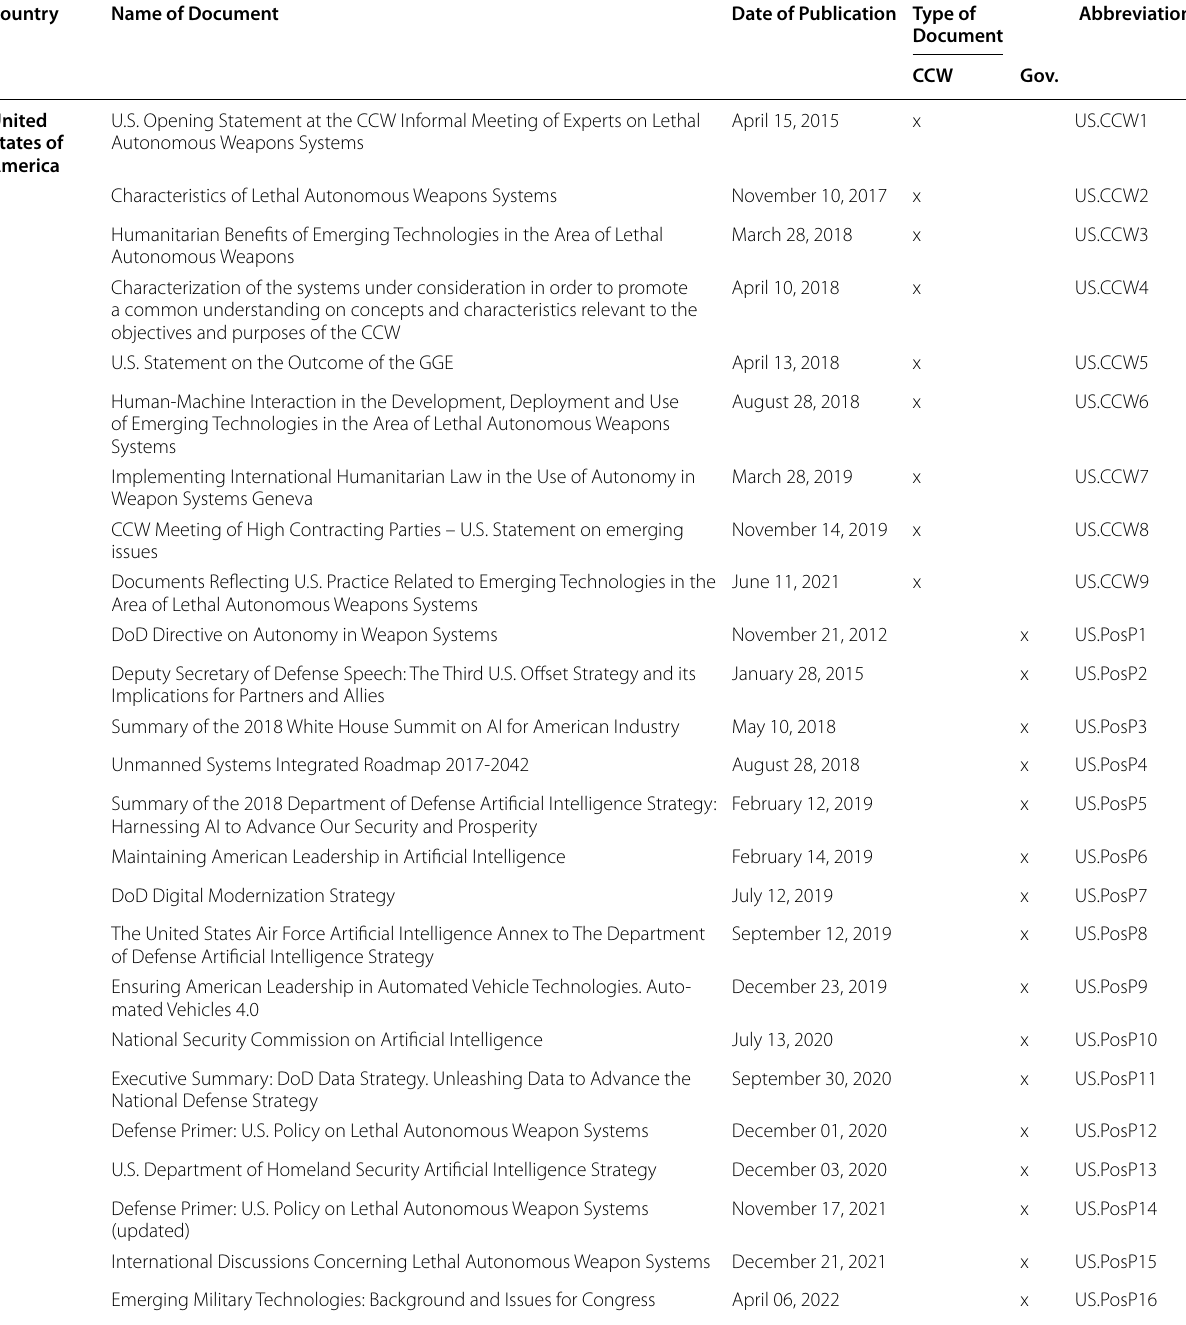
Table 1 Overview of published CCW standpoint papers and governmental documents concerning LAWS of the USA and China